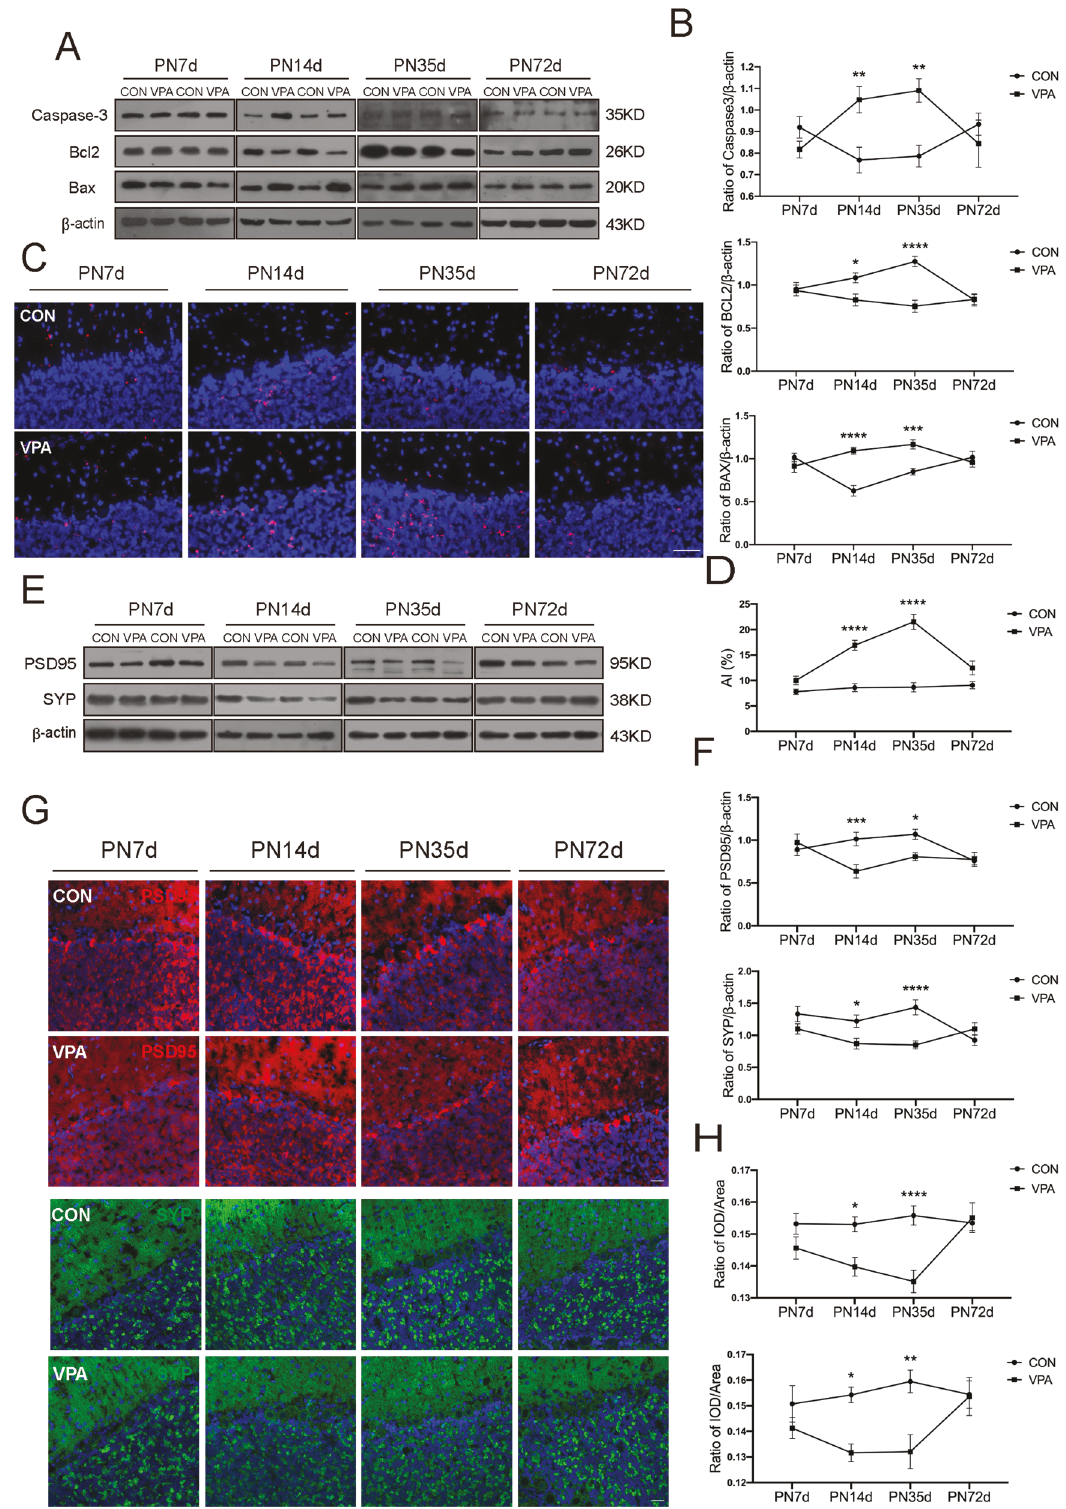
Fig. 3 Dynamic changes of neuronal apoptosis and synaptic dysplasia in the cerebellum of VPA-induced rats. A , B Immunoblots and quanti fi cation exhibited expression levels of Caspase3, Bcl2, and Bax at different neurodevelopmental stages. C , D Representative images (bar = 50 μ m) and quanti fi cation of TUNEL staining also showed increased neuronal apoptosis in the VPA group. E , F Western blotting showed synaptic markers, PSD95 and SYP, in the cerebellum. G , H Immuno fl uorescence staining (bar = 25 μ m) exhibited consistent alterations in PSD95 and SYP protein expressions in VPA-induced rats. Data are expressed as mean ± SEM. Two-way ANOVA followed by Sidak post hoc. (* P < 0.05, ** P < 0.01, *** P < 0.001, **** P < 0.0001, sample sizes ( n ): n =